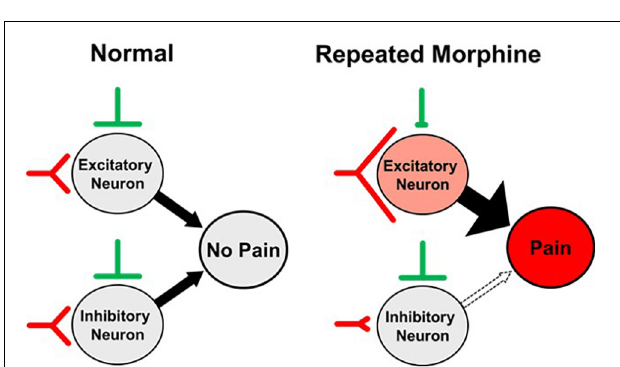
FIGURE 9 | Proposed synaptic mechanism of opioid-induced hyperalgesia (OIH). Repeated morphine causes hyperalgesia (pain) by increasing excitatory input and decreasing inhibitory input to excitatory neurons but disinhibition of inhibitory neurons in the spinal dorsal horn (SDH), leading to differential effects on cell